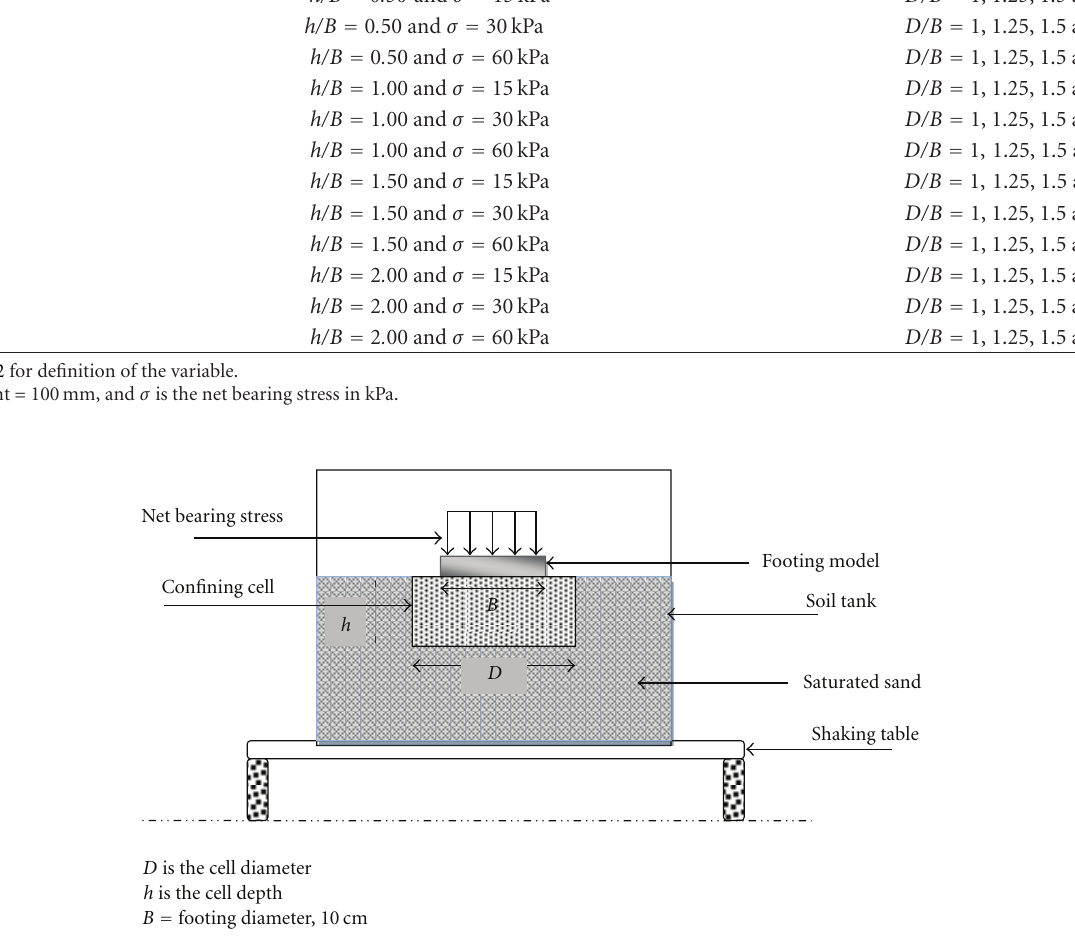
Figure 2: Geometric parameters of confined sand foundation model on shaking